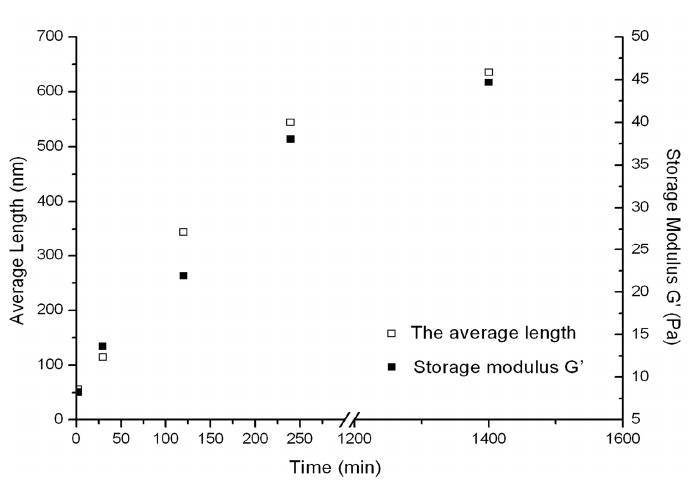
Figure 4. Kinetics of the reassembled length of RADA16-I nanofibers obtained from AFM and increase in the elasticity of RADA16-I scaffold hydrogel after sonication followed by rheometry. Storage modulus G' (Back square) is shown as a function of time (right y axis) and of the average length (red square) of the RADA16-I fibers (left y